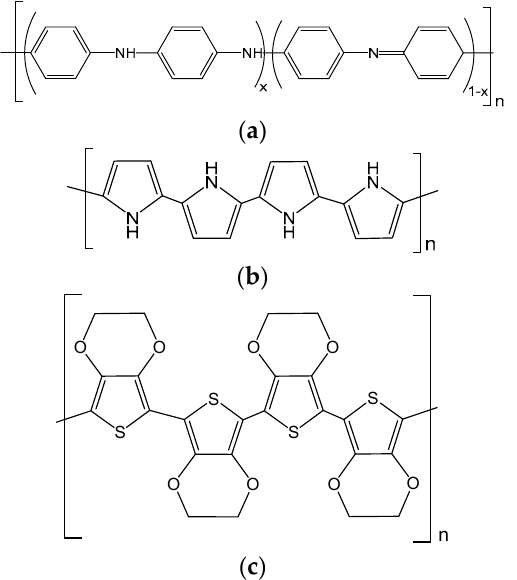
Figure 1. Structures of the most important conducting polymers. ( a ) Polyaniline; ( b ) Polypyrrole; ( c ) Poly-3,4-ethylendioxythiophene.